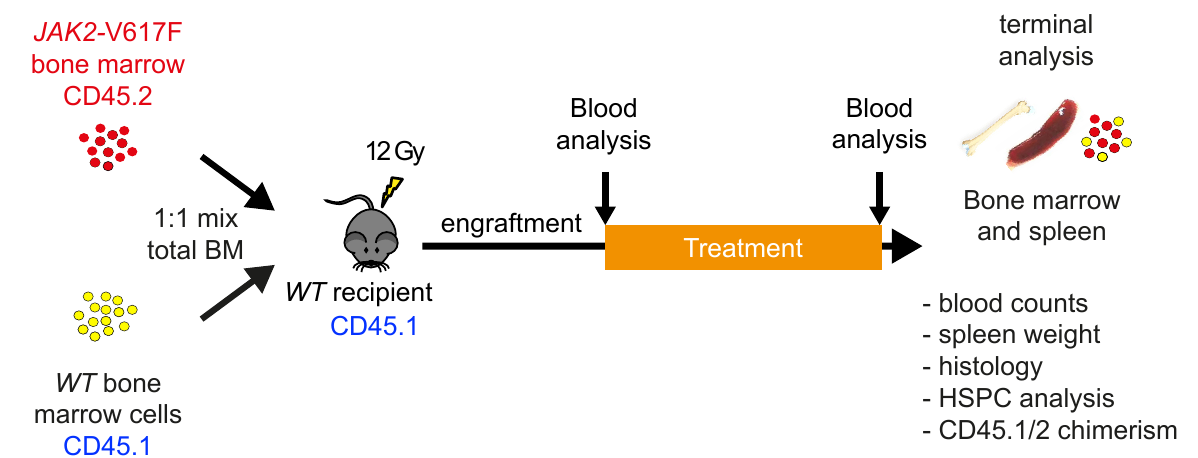
Fig. 2. Experimental setup for candidate drug testing in pre-clinical MPN mouse models with CD45.1/2 reporter gene. Bone marrow (BM) cells expressing JAK2 -V617F + and CD45.2 (red) are mixed with wildtype ( WT) competitor cells expressing CD45.1 (yellow) and injected into lethally irradiated CD45.1 recipient mice (blue). After engraftment, the recipient mice are allowed to develop MPN phenotype and are randomized into treatment or vehicle control groups. Complete blood counts and CD45.1/2 chimerism are determined in peripheral blood at defined timepoints. At the end of the treatment the mice are sacrificed, and terminal analysis of cells and organs is performed.